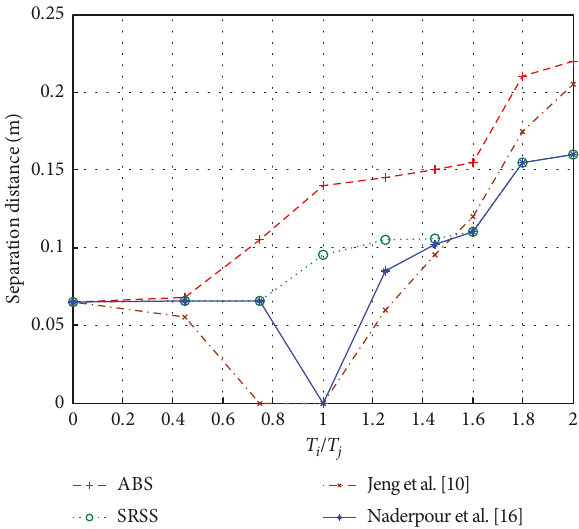
Figure 2: Minimum separation distance vs. ratio between periods of elastic